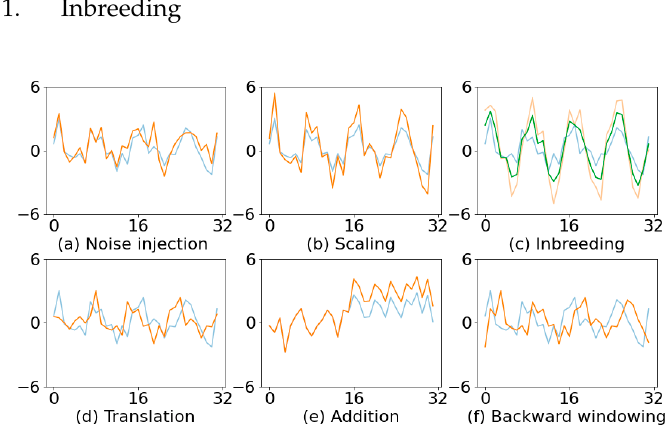
Figure 6. Illustration of data augmentation.